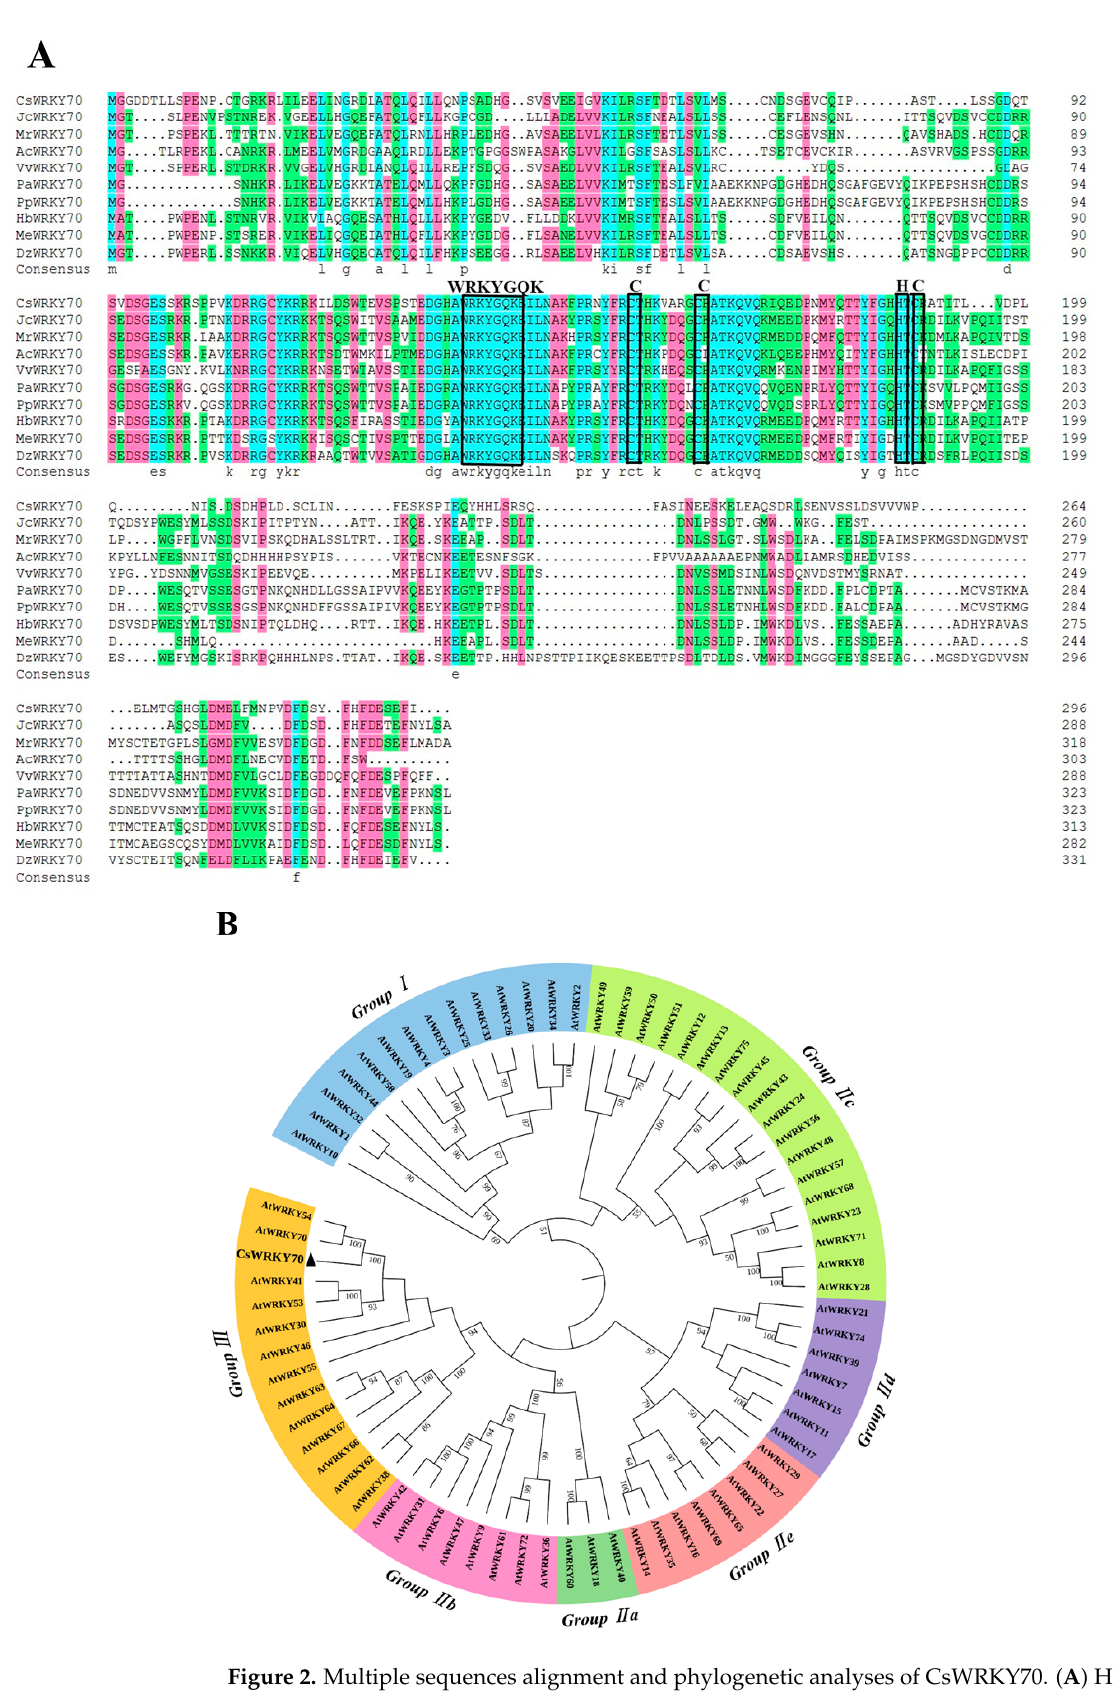
Figure 2. Multiple sequences alignment and phylogenetic analyses of CsWRKY70. ( A ) Homology protein sequence alignment between CsWRKY70 and WRKY70 protein sequences of other species ( Jatropha curcas , Myrica rubra , Actinidia chinensis , Vitis vinifera , Cerasus avium , Amygdalus persica , Hevea brasiliensis , Manihot esculenta , and Durio zibethinus ). Identical or similar amino acids were indicated by blue, red, and green shading. The WRKY domain and C2HC zinc finger were indicated by black boxes. ( B ) Phylogenetic analysis of CsWRKY70 and Arabidopsis -derived WRKY TFs family. CsWRKY70 was marked with a black triangle. 3.4. Subcellular Localization of CsWRKY70 WRKY TFs are typical nuclear proteins with transcriptional activity [31]. CsWRKY70 was predicted to be a nuclear protein using the online software WoLF POSRT. We further verified this result by subcellular localization assays using tobacco. Results showed that CsWRKY70-GFP was localized in the nucleus (Figure 3), while the positive control of GFP- Empty was distributed in the whole cell, indicating that CsWRKY70 is a nuclear localiza- tion protein.